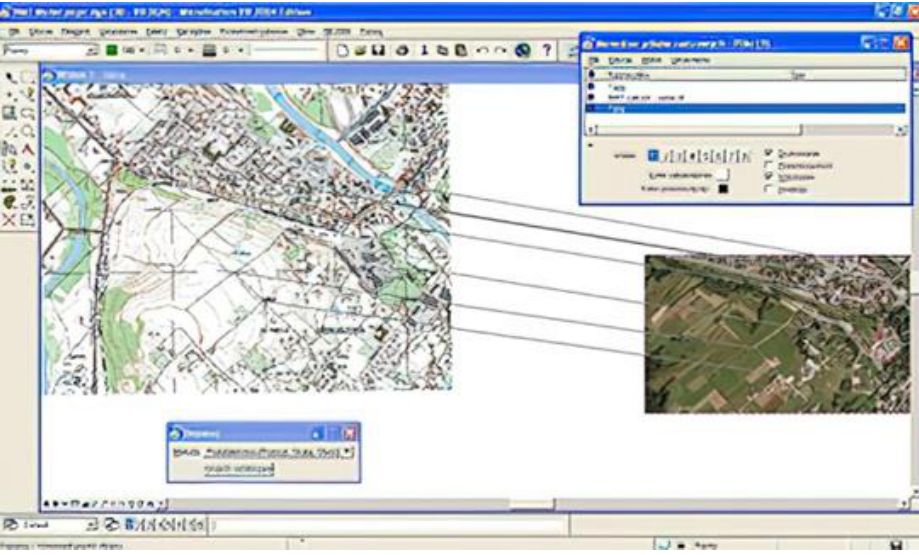
Figure 23. Adjusting the situational details of the map to the aerial photo. After completing the aerial photograph adjustment, the mosaic fragments were merged into one common file and saved in the GeoTiff format (Figure 24).